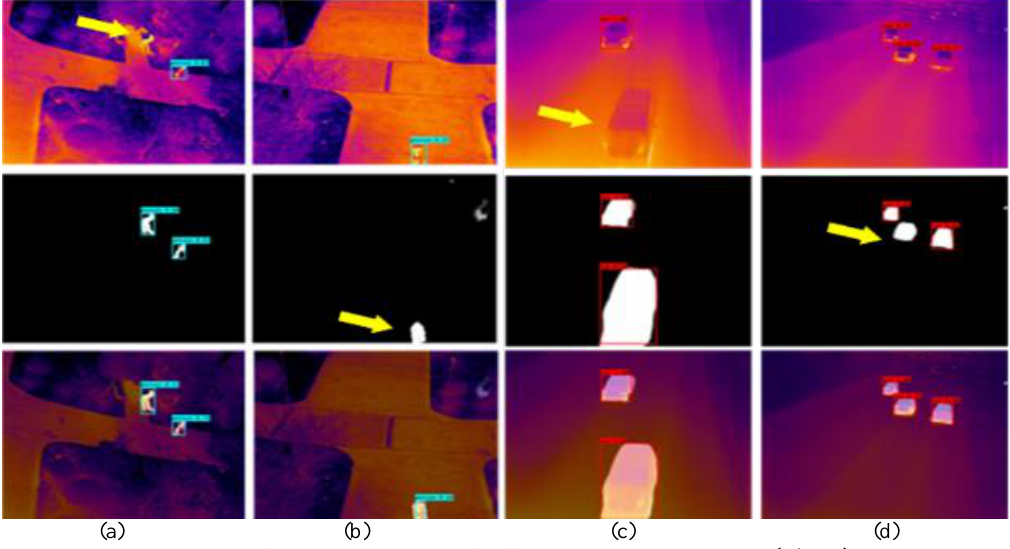
Figure 5. Example results of the detection results of different model trained only on (1 st row) origianl thermal images, (2 nd row) saliency maps, and (3 rd row) fusion images. The arrows indicate some missing